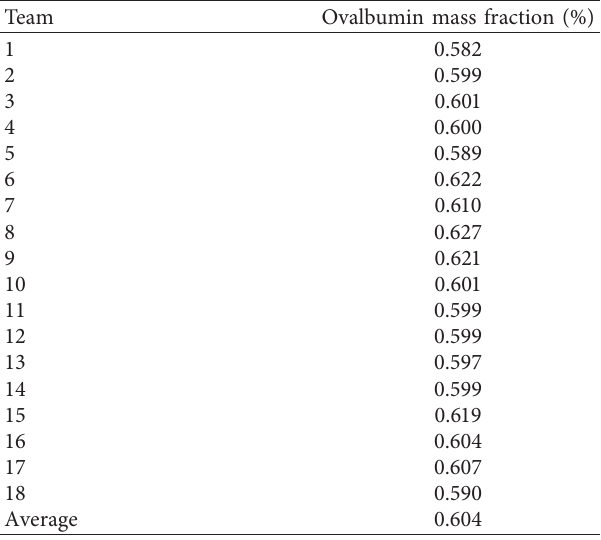
Table 5: Ovalbumin mass fraction measured by 18 teams of